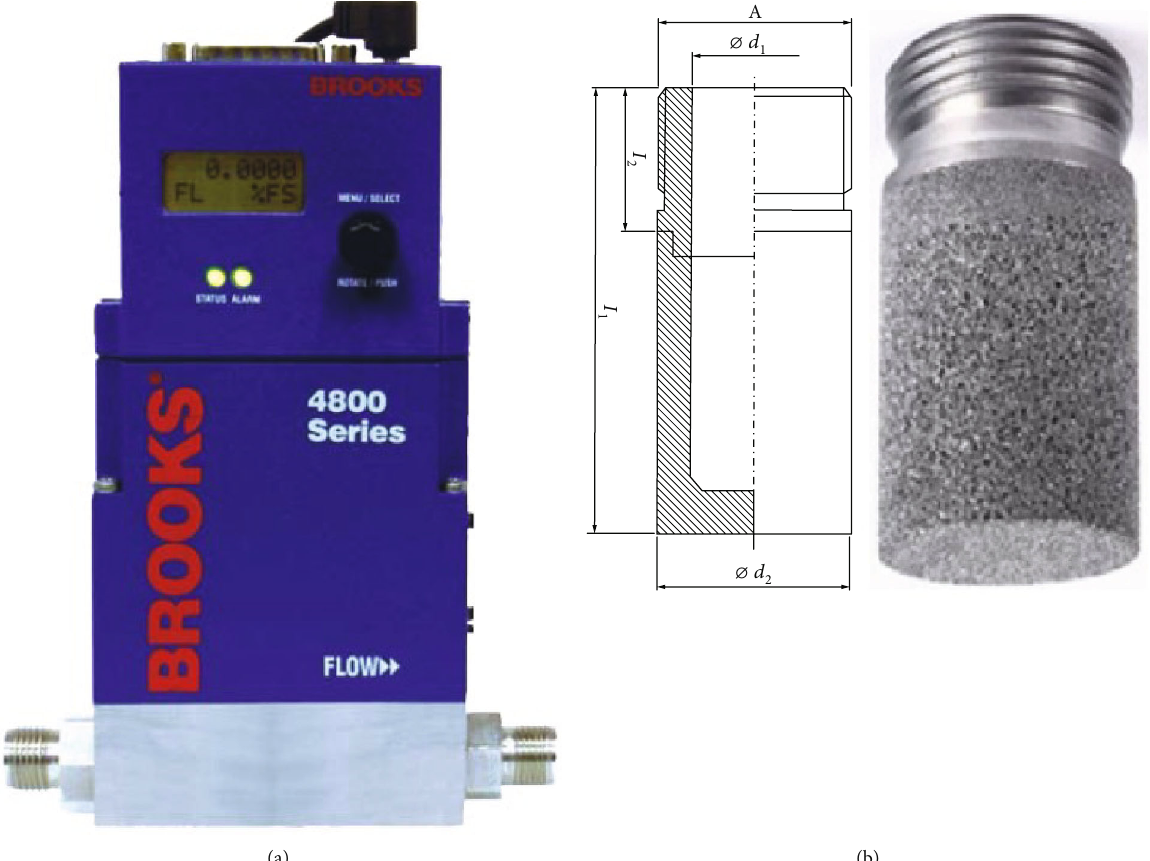
Figure 2: The instrument speci fi cation: (a) mass fl ow controller (Brooks® 4800 Series LOI) for regulating the gas injection rate and (b) porous gas sparger (SIKA-R3 AX) selected for the bubble